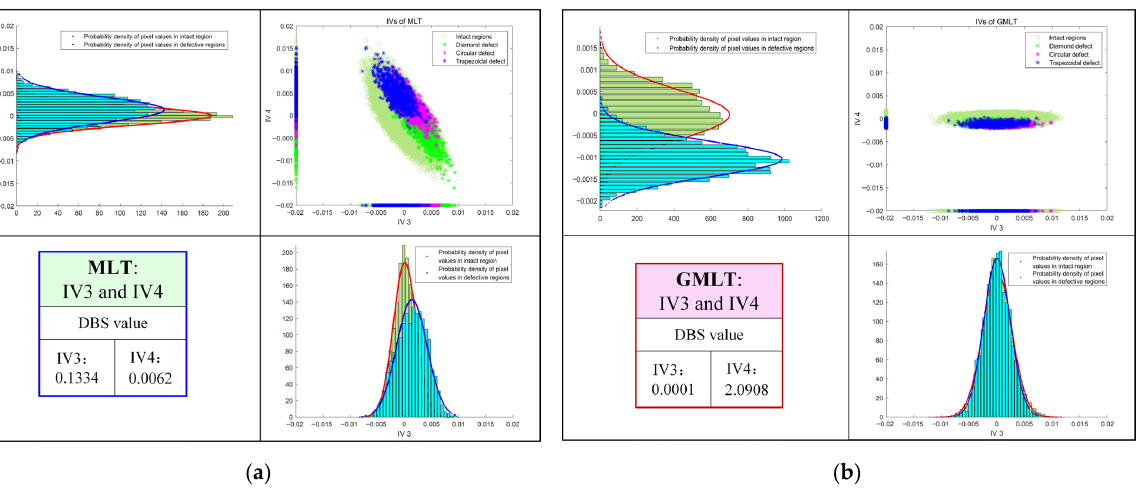
Figure 12. Pixel distribution and respective projections and their probability density plots in IV3 and IV4: ( a ) MLT; ( b ) GMLT.